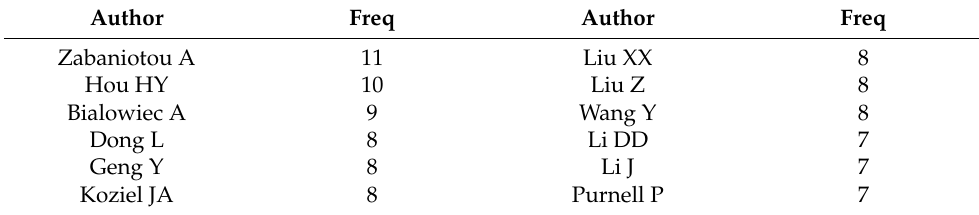
Figure 3. Author’s cooperation network. Table 2. List of Top 12 Authors with the Most Published Numbers.